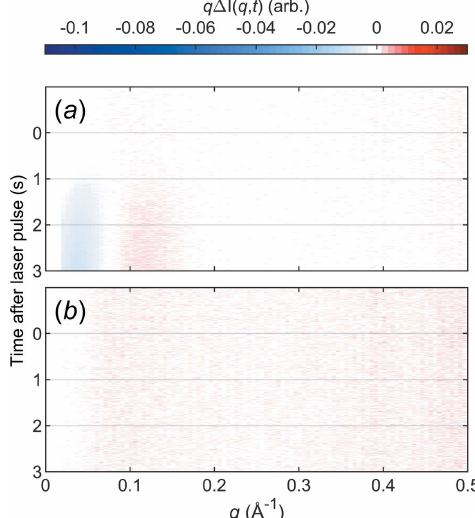
Figure 8 Data from a T-jump TR-XSS experiment on lysozyme. ( a ) Heat subtracted data in the SAXS range for a T-jump on lysozyme in deuterated buffer, starting at 20 (cid:5) C. ( b ) Laser off – laser off difference data for a T-jump starting at 20 (cid:5) C. Note that the colour scale is the same as in Fig. 6 in order to enable comparisons of the